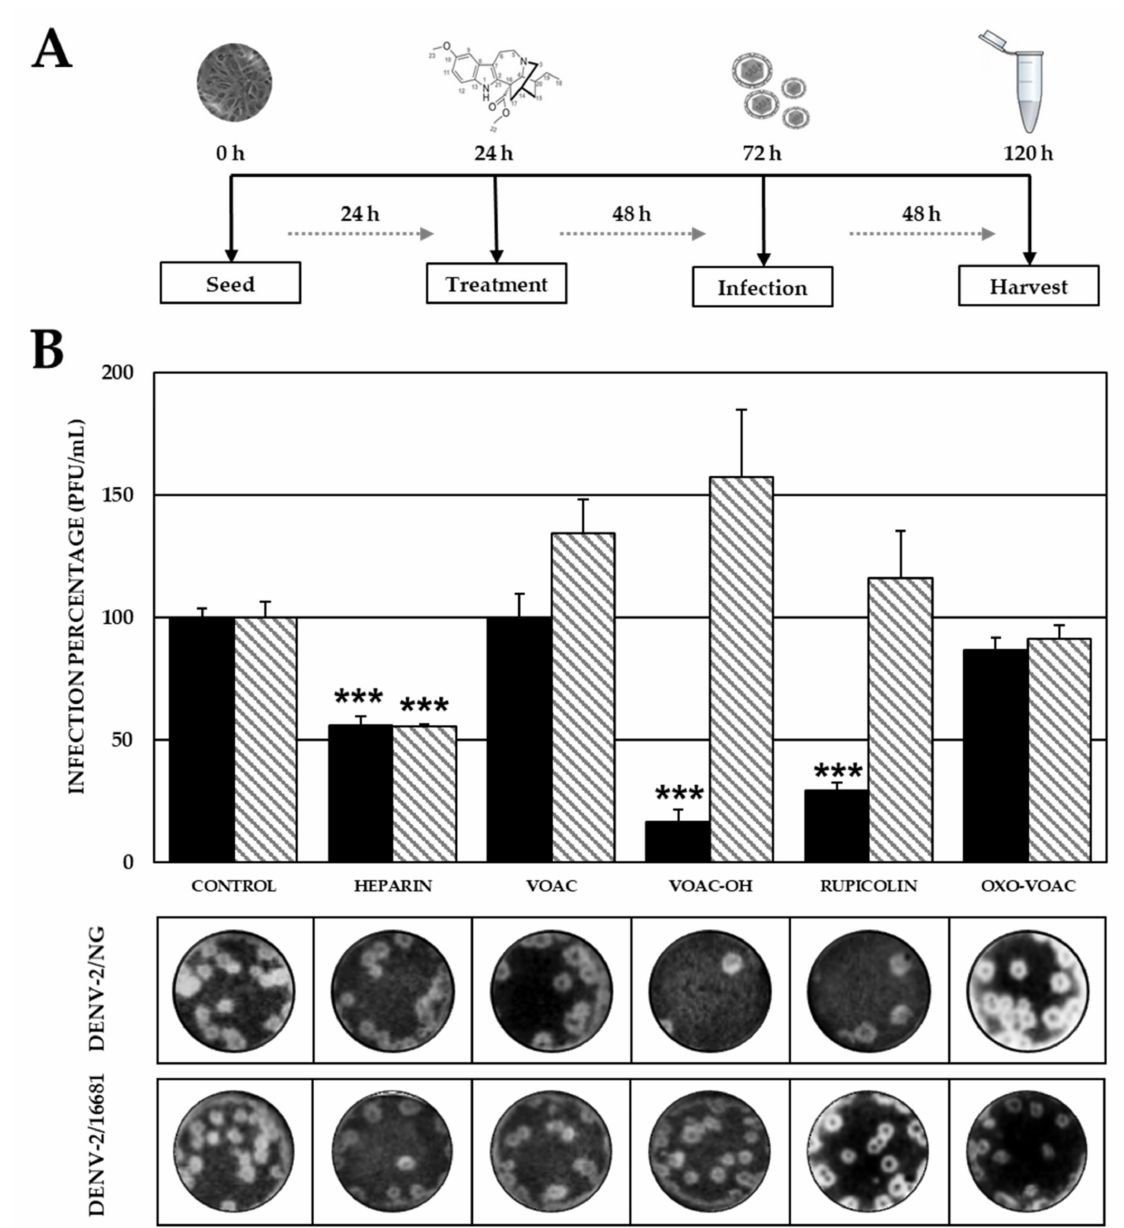
Figure 2. Antiviral effects on viral production (DENV-2) using the Pre-treatment strategy. ( A ) Schematic representation of the Pre-treatment strategy explained in the Materials and Methods section. ( B ) Infection percentage in each experimental condition. Vero cells were pre-treated for 48 h and then infected with DENV-2/NG (Dark bars) or DENV-2/16681 (Clear bars). The asterisks indicate statistically significant differences with respect to the control without compound (*** p < 0.001; t -Student) and error bars indicate standard error of the mean; n : 4. Moreover, it shows representative images of plaque formed in each experimental